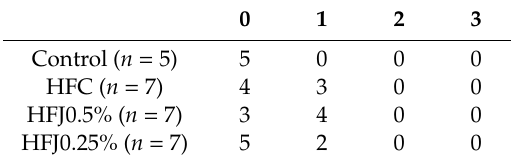
Figure 2. Photomicrographs of hepatic tissue stained by hematoxylin and eosin with a magnification of 40 × . ( A ) Control standard chow (control); ( B ) high-fat diet control group (HFC); ( C ) high-fat diet juçara 0.5% group (HFJ0.5%); ( D ) high-fat diet juçara 0.25% group (HFJ0.25%). The arrows ( ↑ ) indicate the lipid droplets. Table 2. The histopathological score in liver among the groups ( p > 0.05).